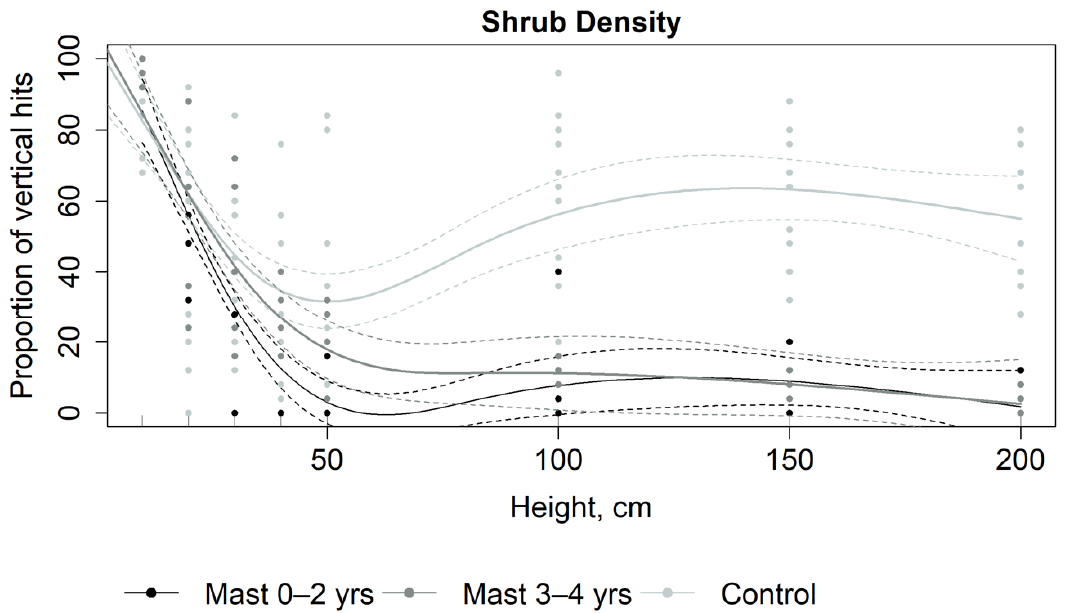
Figure 2. Generalised additive models showing mean proportion of vertical hits of fine fuel as a function of height (cm) for 0–2 years post mastication (black), 3–4 years post mastication (dark grey) and control (light grey). Dashed lines represent the 95% confidence interval around the mean. GAM diagnostics are provided in the Appendix A, Table A1.